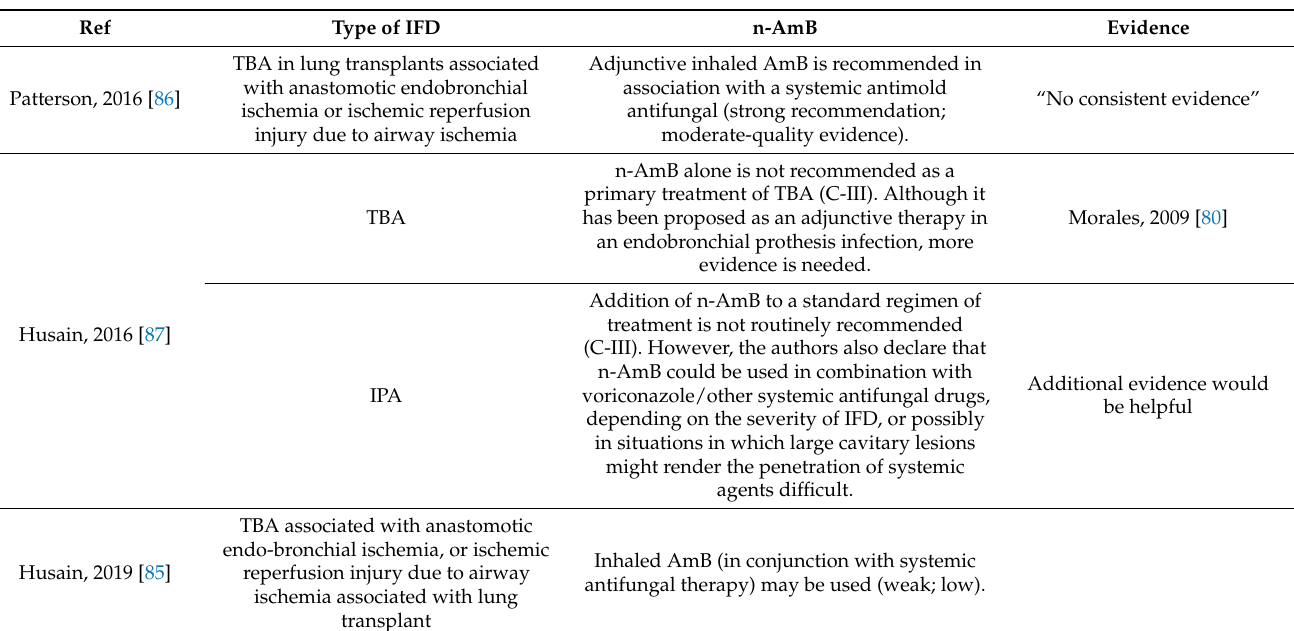
Table 1. Guidelines for the use of nebulized AmB in treatment for invasive mold infections in lung transplant